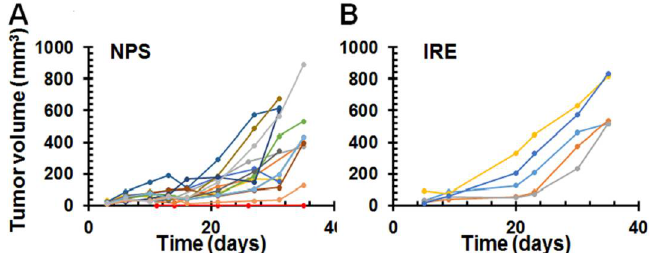
pulses). Each line represents a single tumor growth in one mouse.